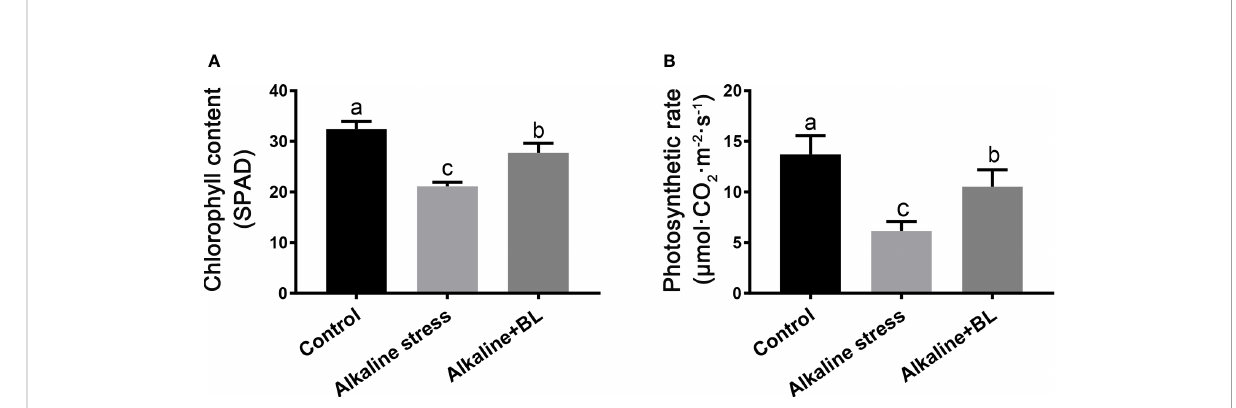
FIGURE 2 Effects of exogenous BL treatment on chlorophyll content (A) , photosynthesis rate (B) of M. hupehensis seedlings under alkaline stress. The data represent the mean ± SD of three biological replicates. Different lowercase letters indicate signi fi cant differences according to Fisher ’ s least signi fi cant difference ( P < 0.05).